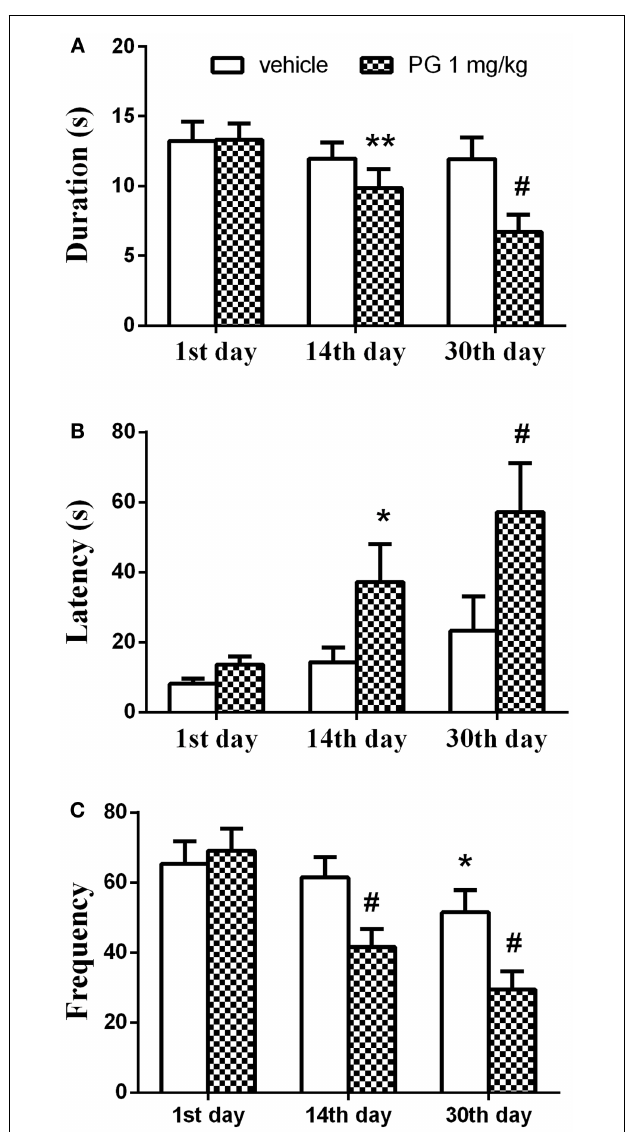
FIGURE 5 | In 4-min paired agonistic interactions, singly housed mice were confronted with non-aggressive group-housed partners . Chronic administration of PG at the dose of 1mg/kg over 30days reduced aggressive behavior in singly housed mice exhibiting aggressive behavior during the first agonistic interaction. (A) Graph shows the duration of aggressive activities.The duration was significantly reduced after 14 and 30days of PG 1mg/kg administration, compared to the scores of vehicle treated controls in the first day.The effect was more prominent after 30days. (B) Graph shows latency to the first aggressive action. Latency prolonged in PG treated mice after 14 and 30days of PG application in comparison to controls. Again this effect was greater after longer administration. (C) Graph displays number of aggressive actions. Frequency decreased over the course of the experiment.Vehicle treated mice also showed significant reduction in the frequency of aggressive actions between the 1st and 30th day. However, this change in frequency was not as prominent as in PG treated animals. All values represent group means ± SEM. * p < 0.05, ** p < 0.005, # p < 0.0001 compared to the vehicle treated animals on the first day of agonistic